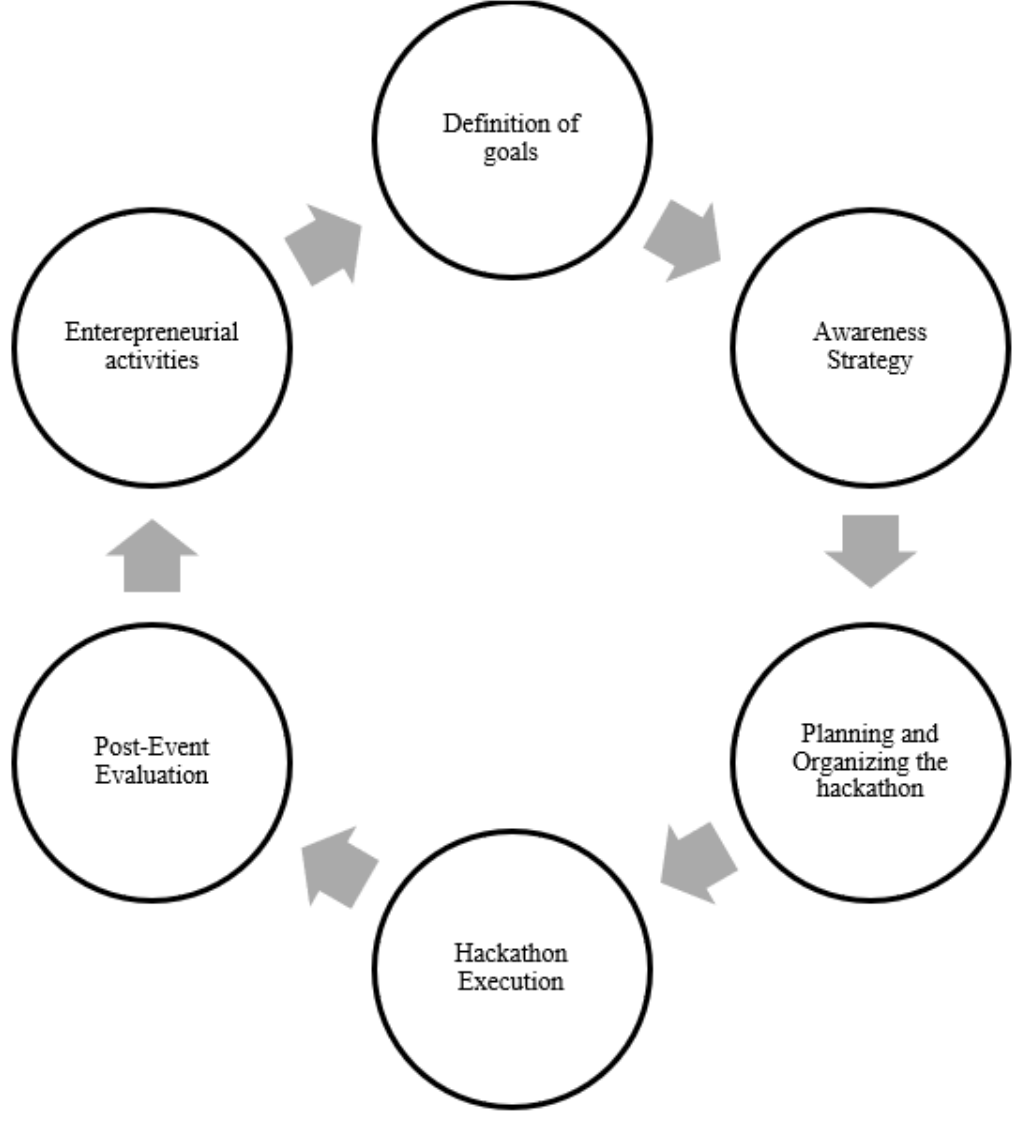
Figure 3. The updated model for organizing hackathons.